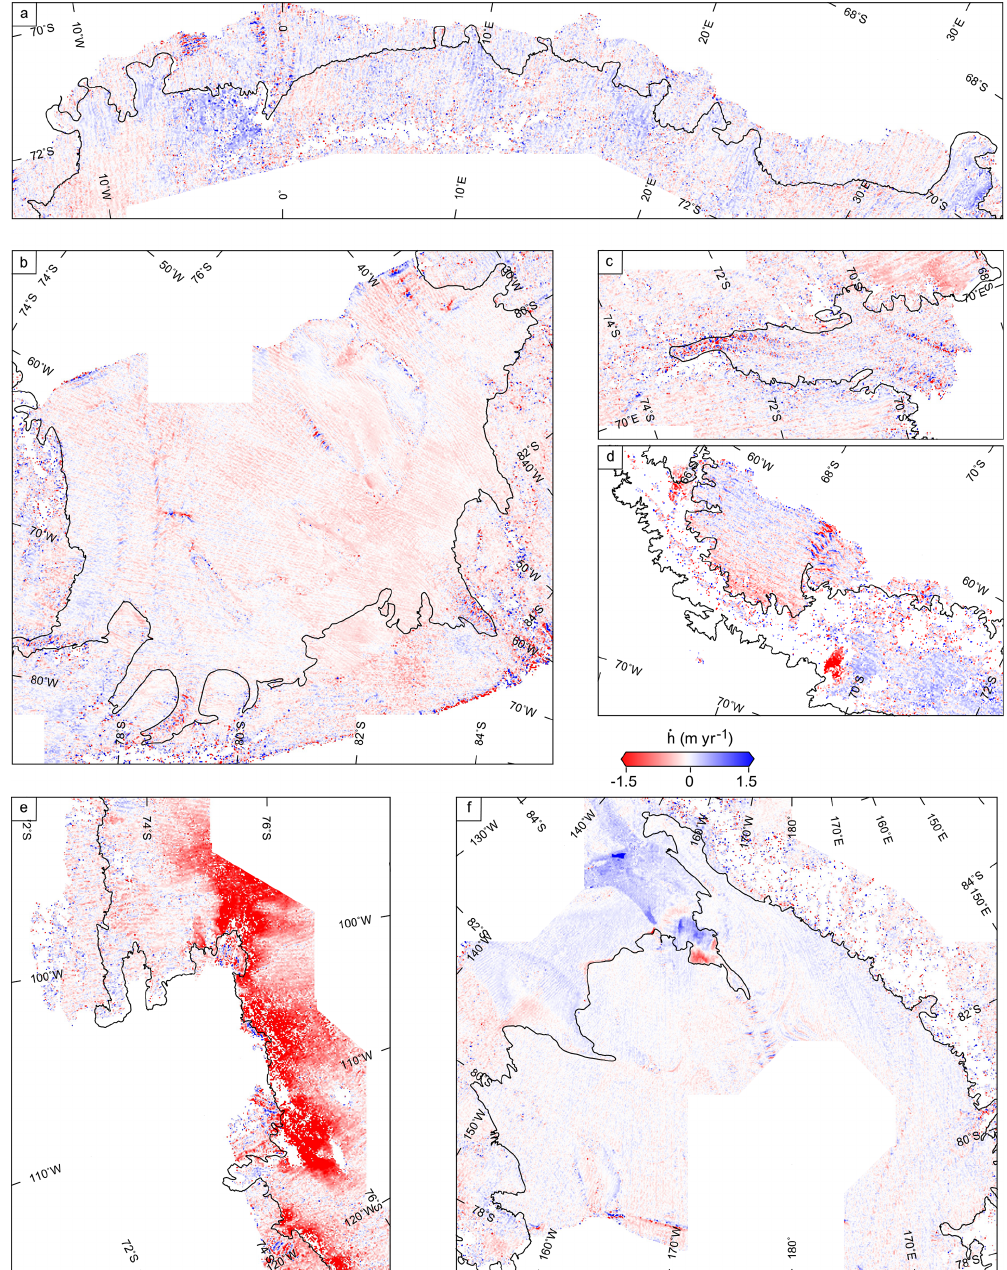
Figure A3. Elevation change ( ˙ h ) for (a) Dronning Maud Land, (b) Filchner–Ronne Ice Shelf, (c) Amery Ice Shelf and (d) Antarctic Peninsula. (e) Amundsen Sea sector and (f) Ross Ice